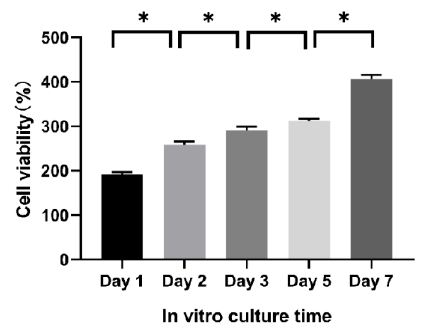
Figure 9. Human neuroblastoma SH-SY5Y cell proliferation rate in the alginate-gelatin-interpenetrating polymer network (A-G-IPN). * means that there are statistical significances between the two adjacent culture periods ( p < 0.05).